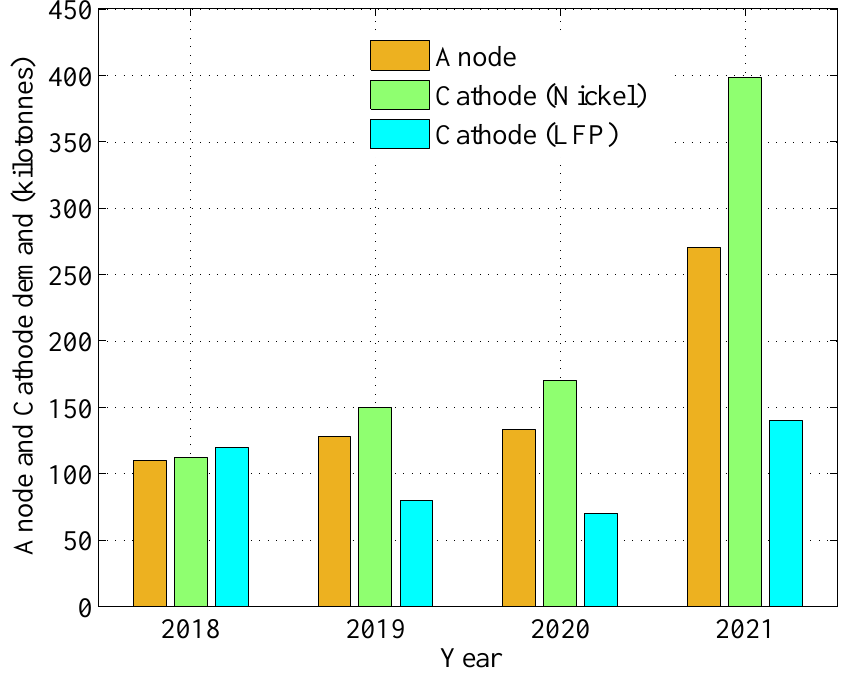
Figure 6. Battery cathode and anode material demand, spanning from 2018 to 2021.